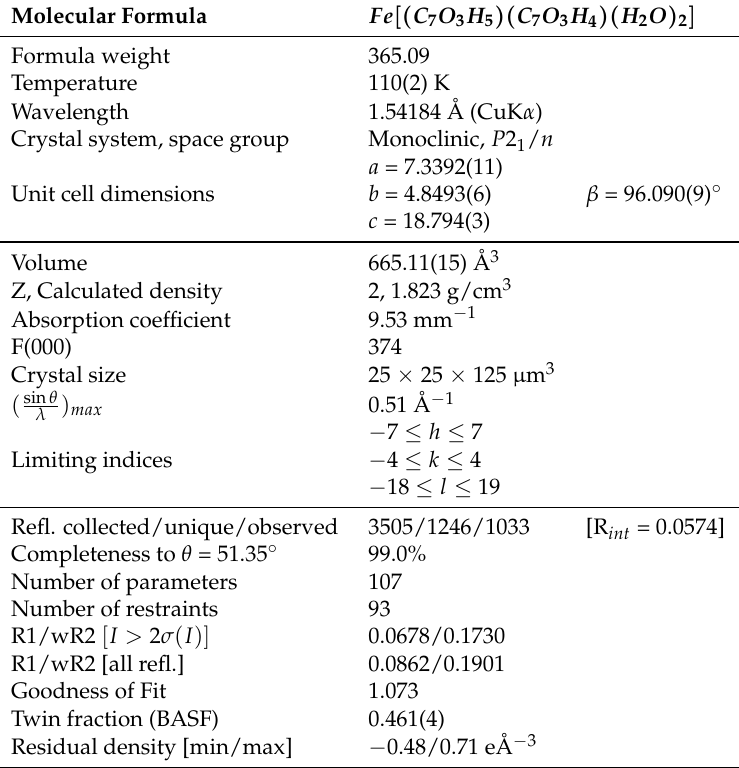
Table 2. Measurement